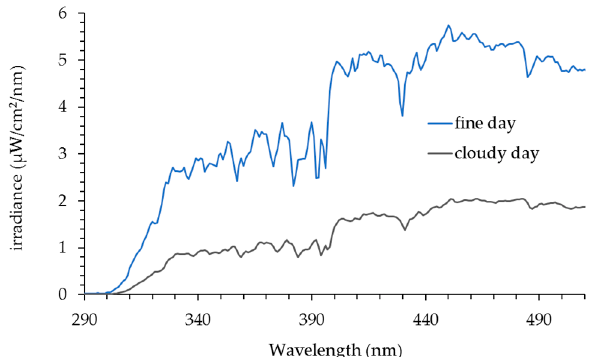
Figure 4. Spectral distribution (280–500 nm) of sunlight measured at noon on a fine day and on a cloudy day in May in Yokohama (35° N).